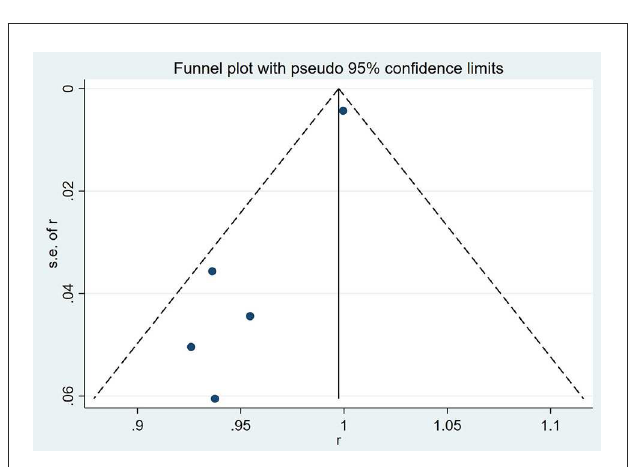
FIGURE5 Funnel plot analysis of favorable clinical outcome at follow